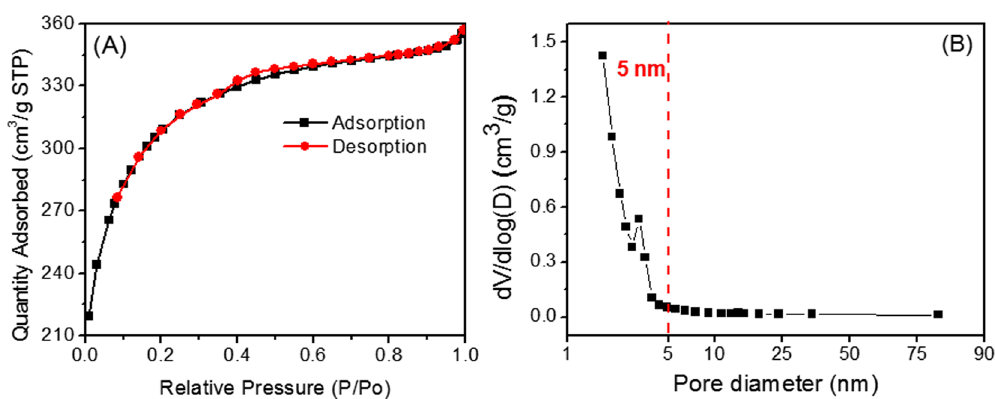
Figure 2. ( A ) N 2 absorption and desorption isotherms linear plot and ( B ) pore size distribution of the ECF